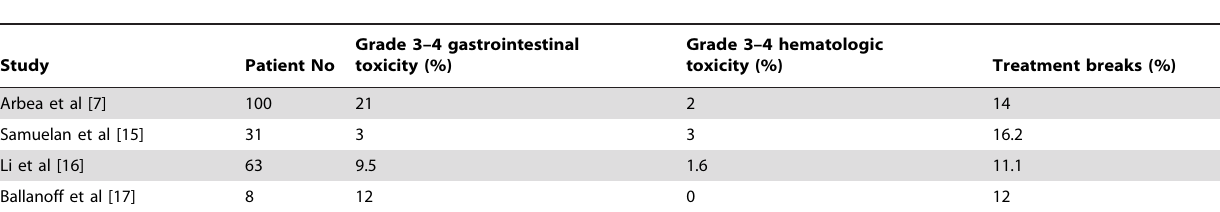
Table 3. Treatment toxicity reported in studies using IMRT and chemotherapy for the treatment of locally advanced rectal cancer.